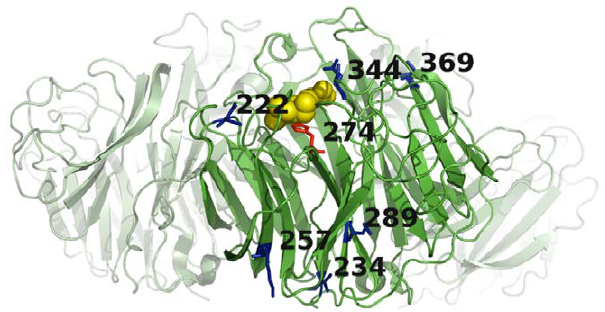
Figure 6. Sites of the mutations mapped onto the neuramin- idases protein structure. Shown in dark green is one monomer from an N1 neuraminidase crystal structure ([37], PDB code 3BEQ]. Residue 274 (N2 numbering) is shown in red, and the sites of the secondary mutations (N1 numbering) are shown in blue. Oseltamivir (yellow spheres) is modeled in its binding site based on a related crystal structure ([83], PDB code 2HU0). The other three monomers of the full neuraminidase tetramer are shown in light green, based on modeling from a related crystal structure ([83], PDB code 2HU0). The image was rendered with